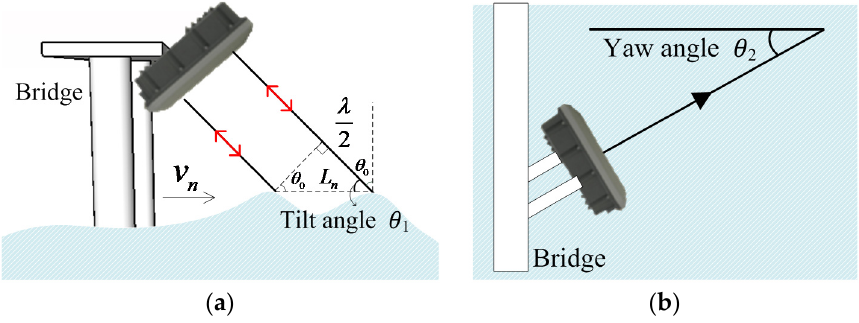
Figure 1. Bragg scattering and surface velocity measured by a radar wave current meter: ( a ) lateral view; and ( b ) top view.